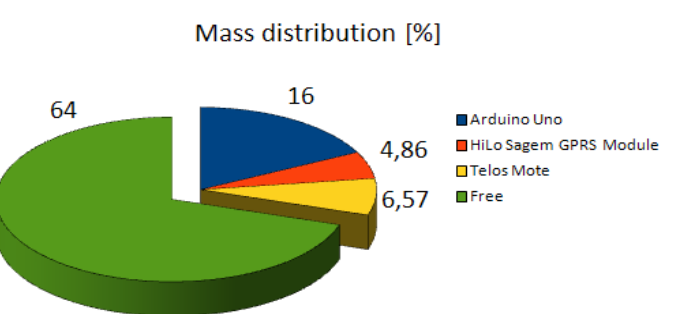
Figure 8. Quadrotor on-board mass